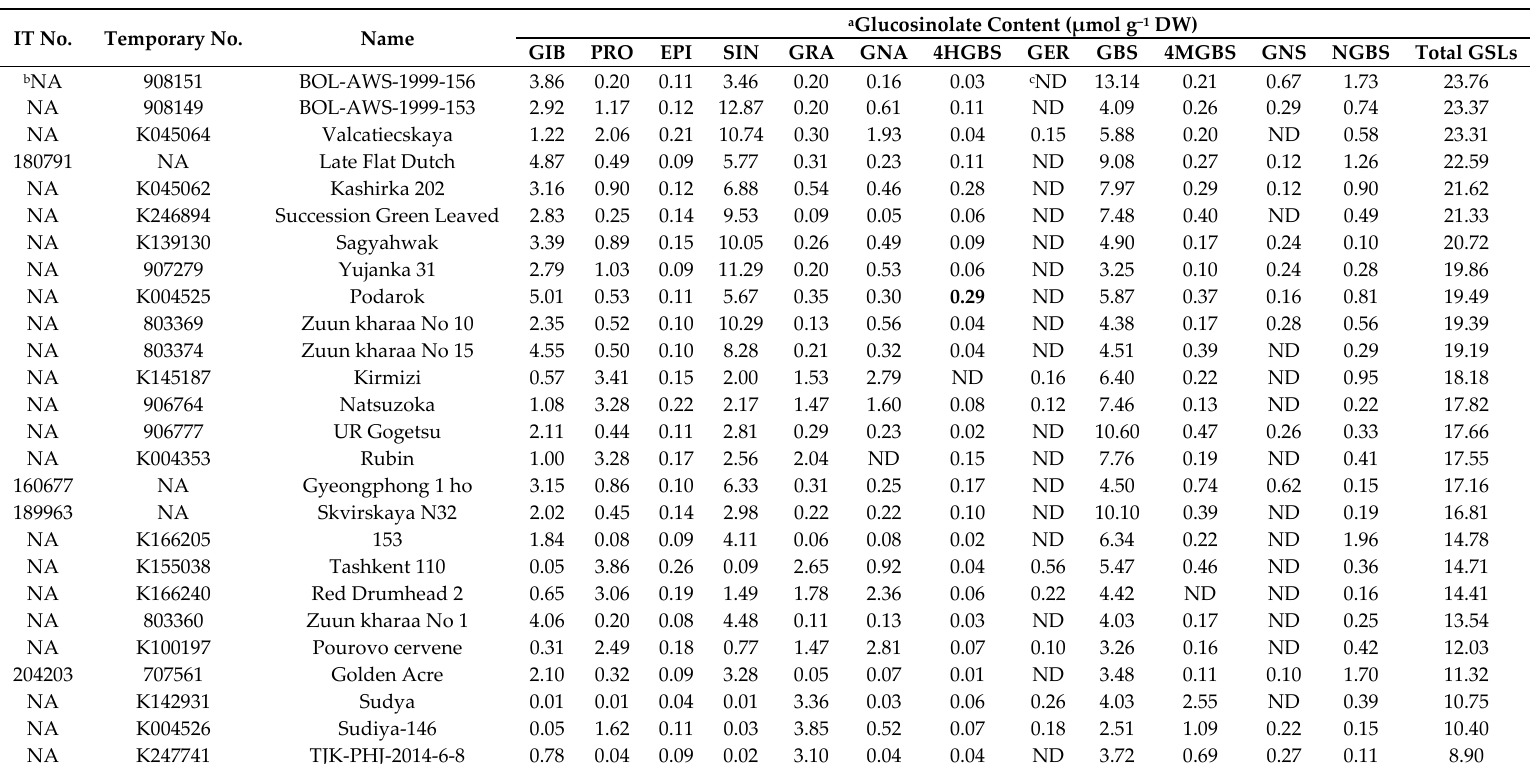
Table 3 . Selected cabbage genotypes with the higher glucosinolate